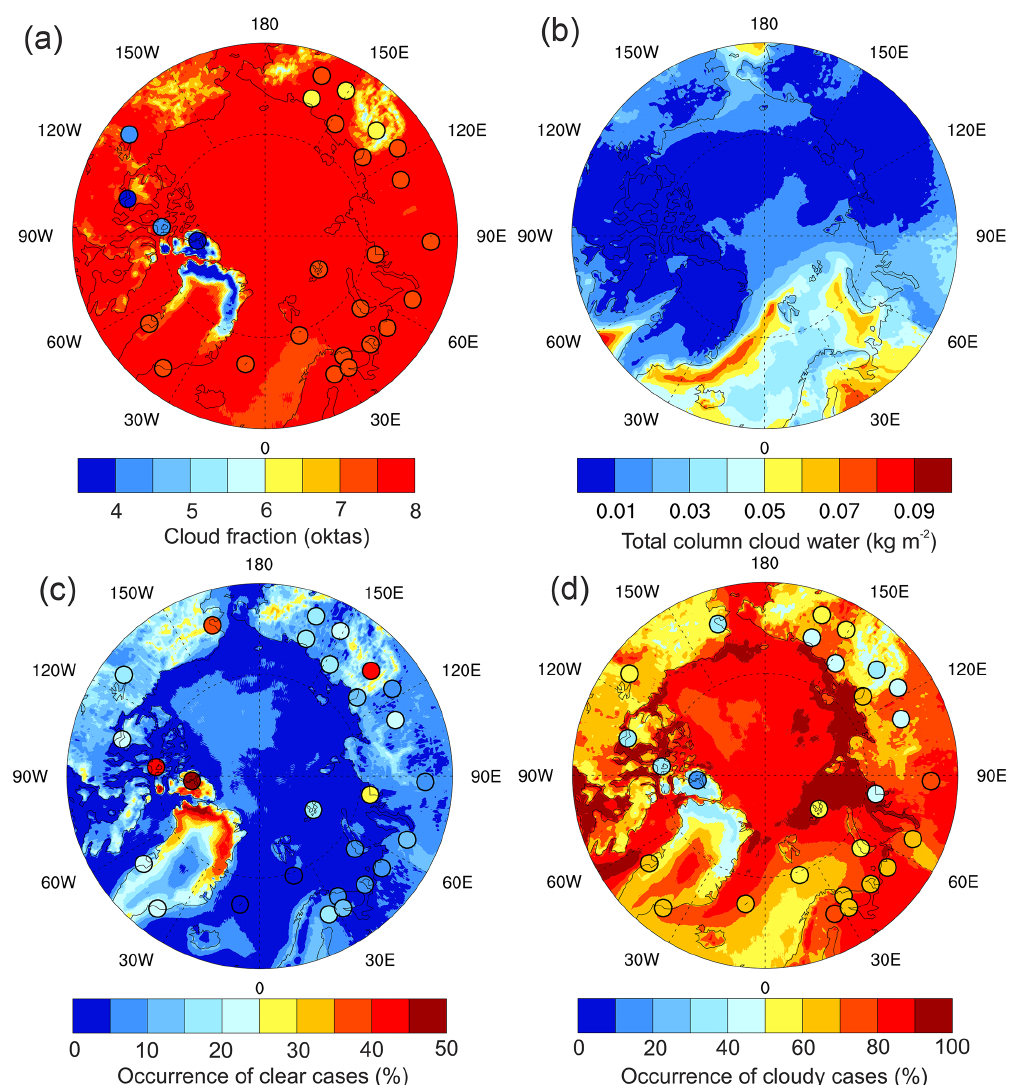
Figure 2. (a) Median cloud fraction, (b) median total column (liquid and frozen) cloud water, (c) occurrence of clear (cloud fraction ≤ 1 / 8) cases and (d) occurrence of overcast (cloud fraction ≥ 7 / 8) cases in December–February 2009–2018. The colours inside the circles in (a) – (c) show synoptic cloud observations at the radiosounding stations, whereas the fields in (a) – (d) are based on